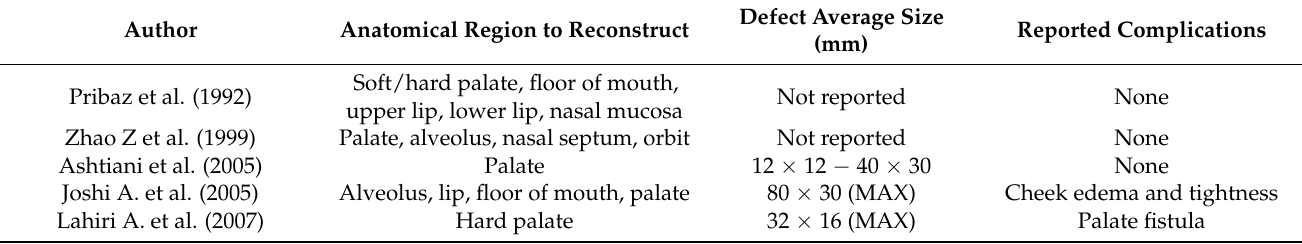
Table 2. Flap reconstruction details and additional reported